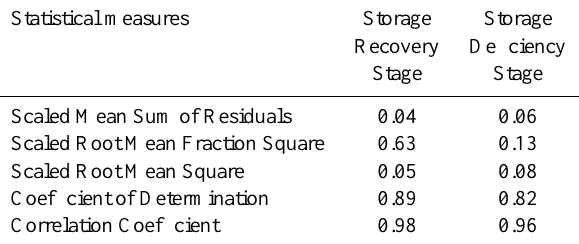
Figure 8. Variation in (a) catchment contributing areas and (b) runoff coefficient, associated with these areas for various daily rainfall; here RO d and RO r are runoff coefficients under storage deficiency and storage recover stages, respectively, and A d d and A d are contributing areas during those stages